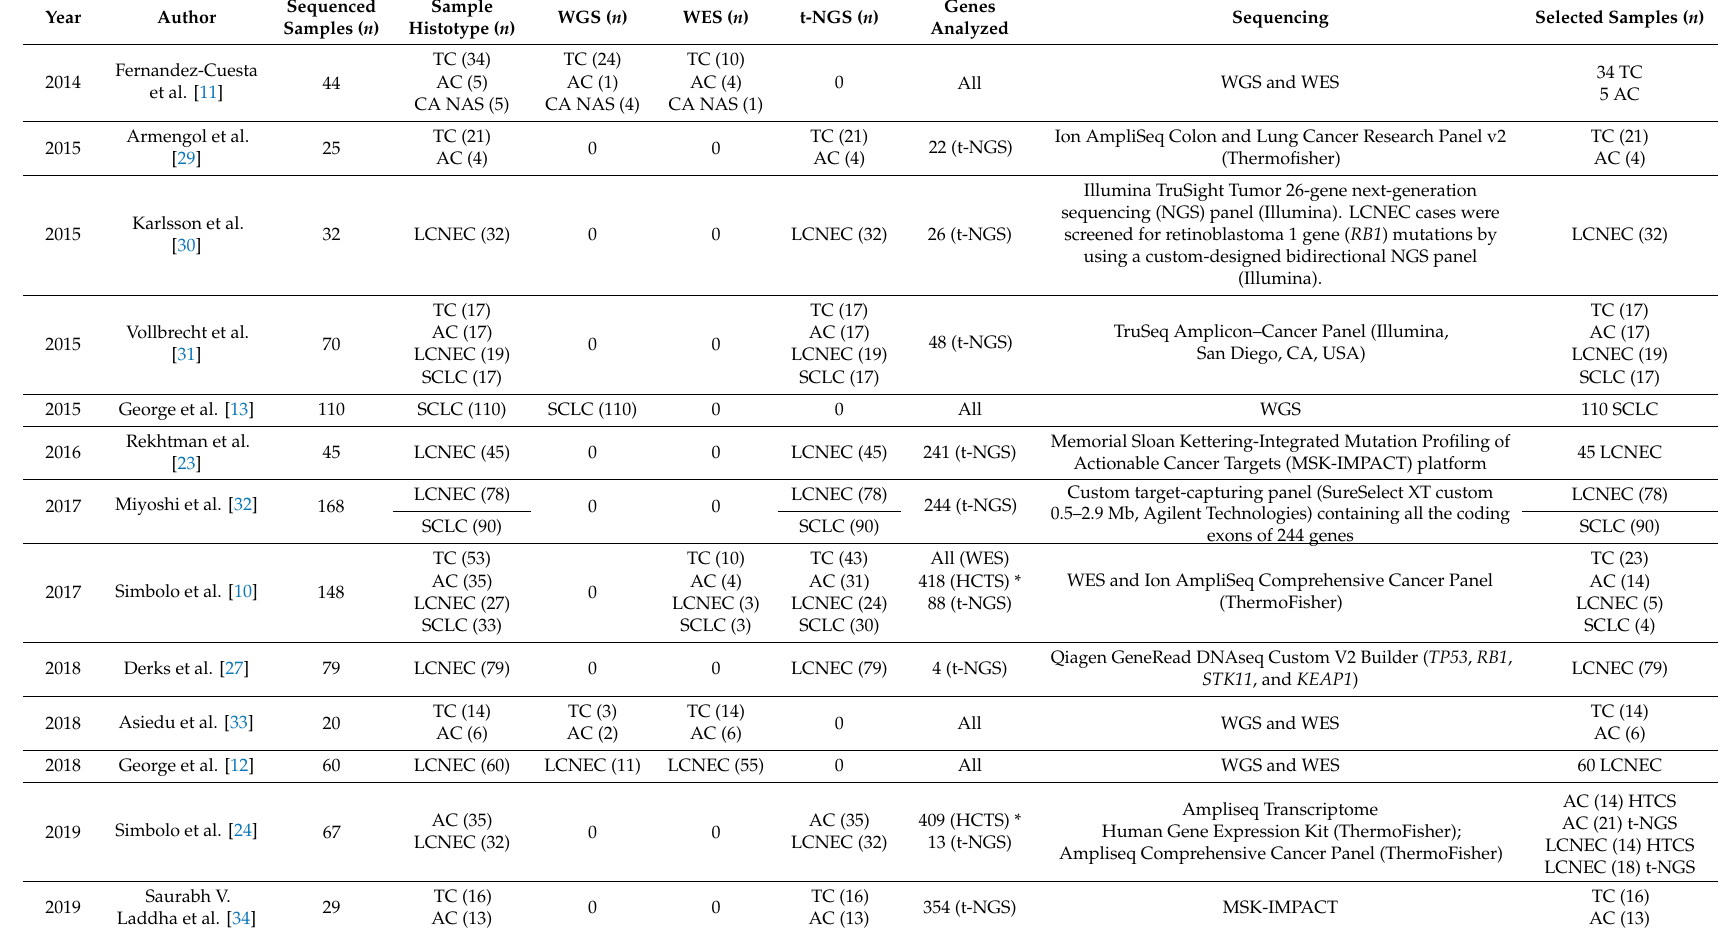
Table 1. Studies with available original next generation sequencing data selected for the